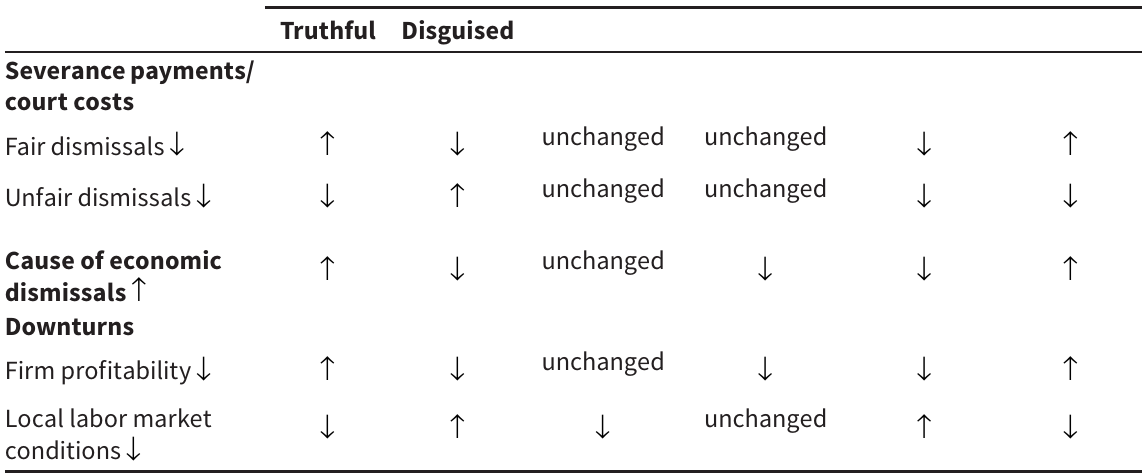
Table A3 Effects of EPL